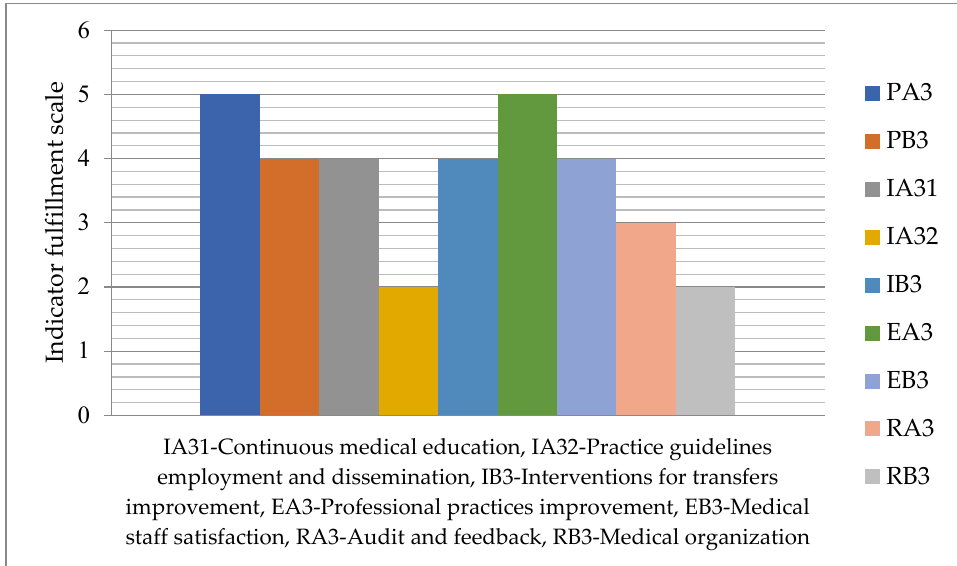
Figure 4. Fulfillment degree for labor practices responsibility indicators.